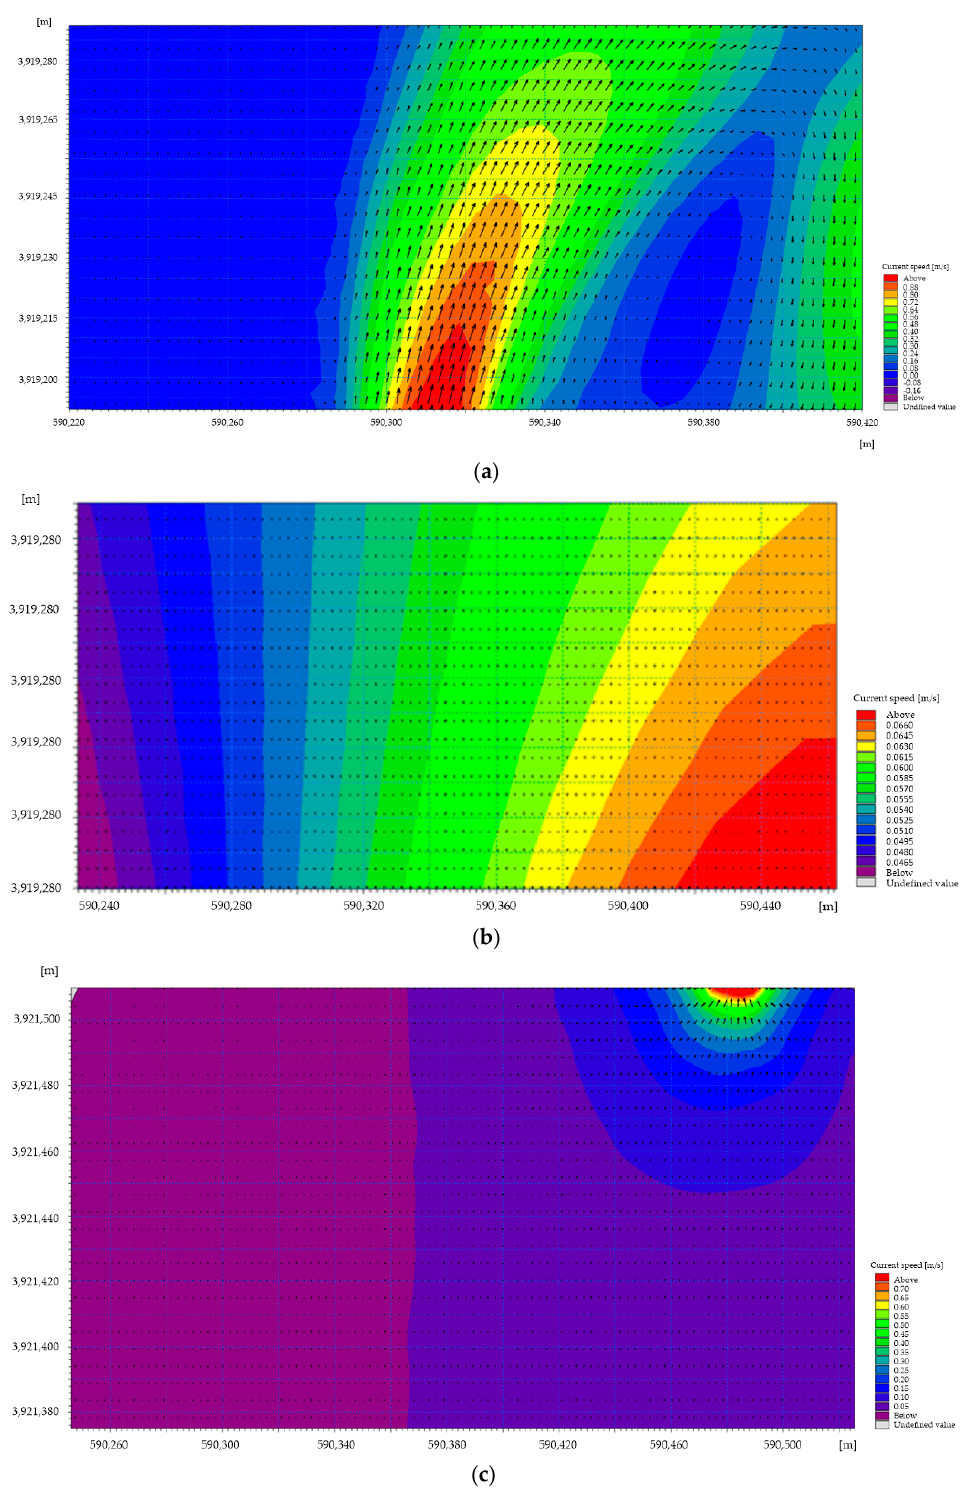
the size and direction of the velocity.